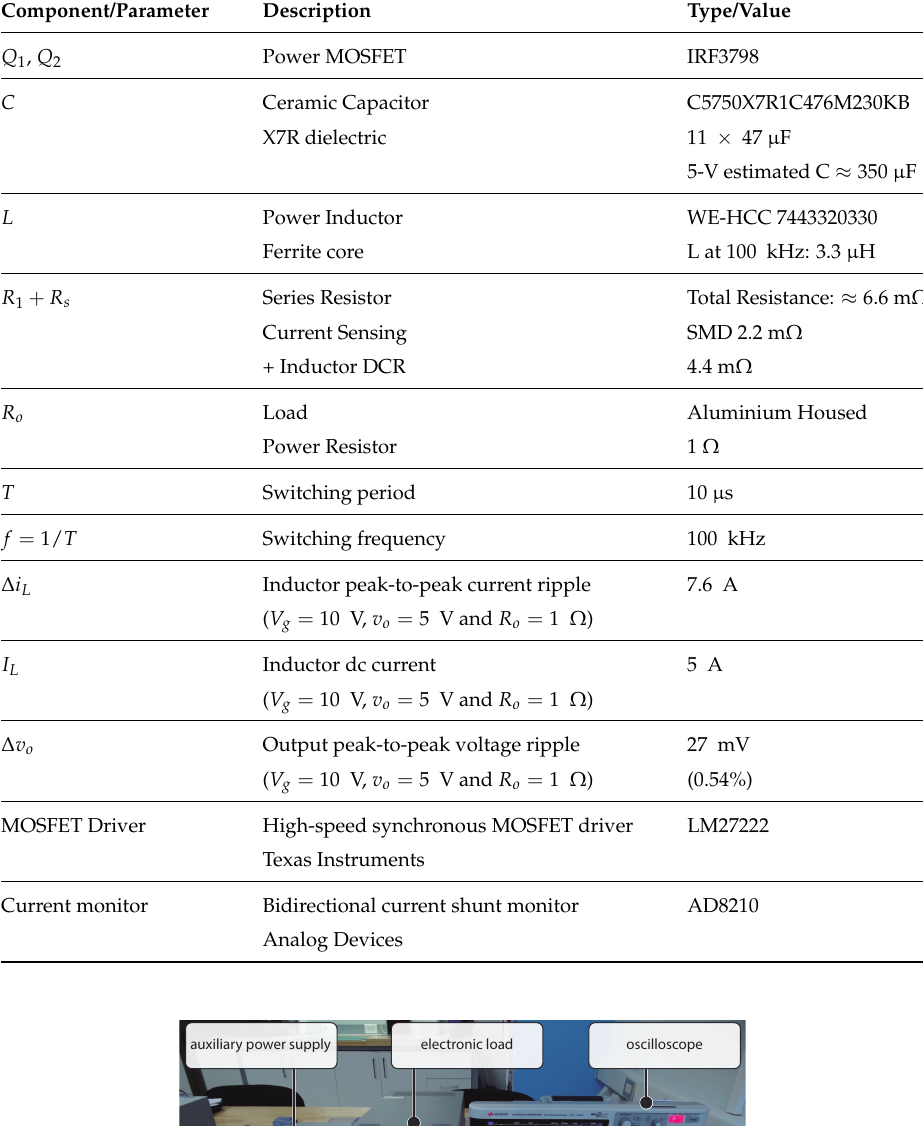
Table 1. Components and parameters of the synchronous buck converter